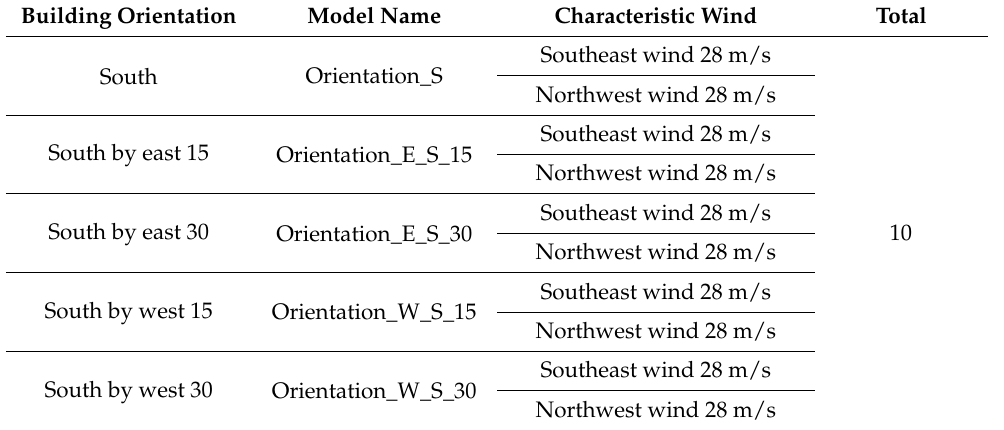
Table 1. Orthogonal experiment